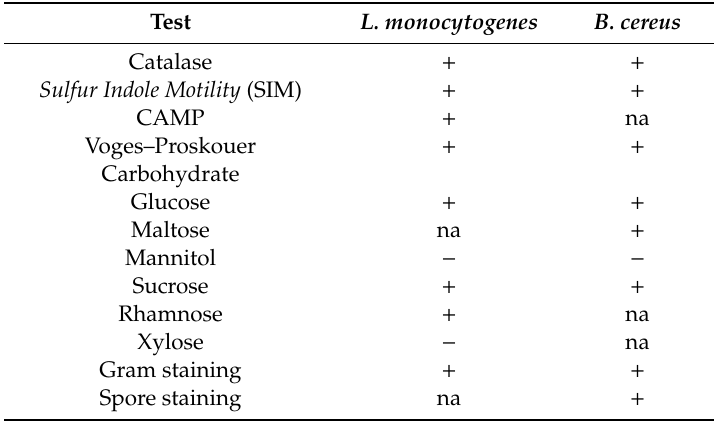
Table 2. Gram and spore staining, and biochemical tests of L. monocytogenes and B. cereus. Test